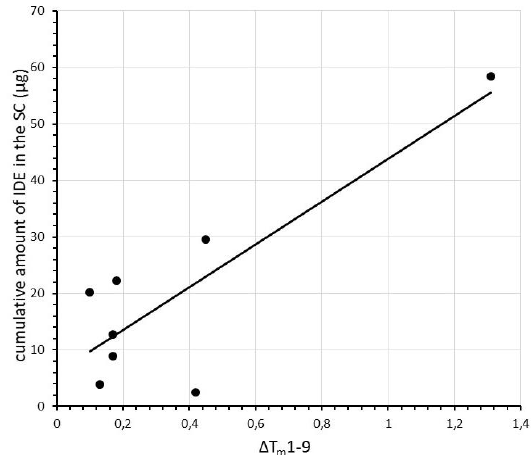
Figure 8. Relationship between the cumulative amounts of IDE penetrated in the stratum corneum (SC) and T m differences (ΔT m 1–9) between the first and the last scan. Each data represents the mean of three different experiments. Standard deviations (S.D.) were omitted for clarity and were within 5% for T m values.